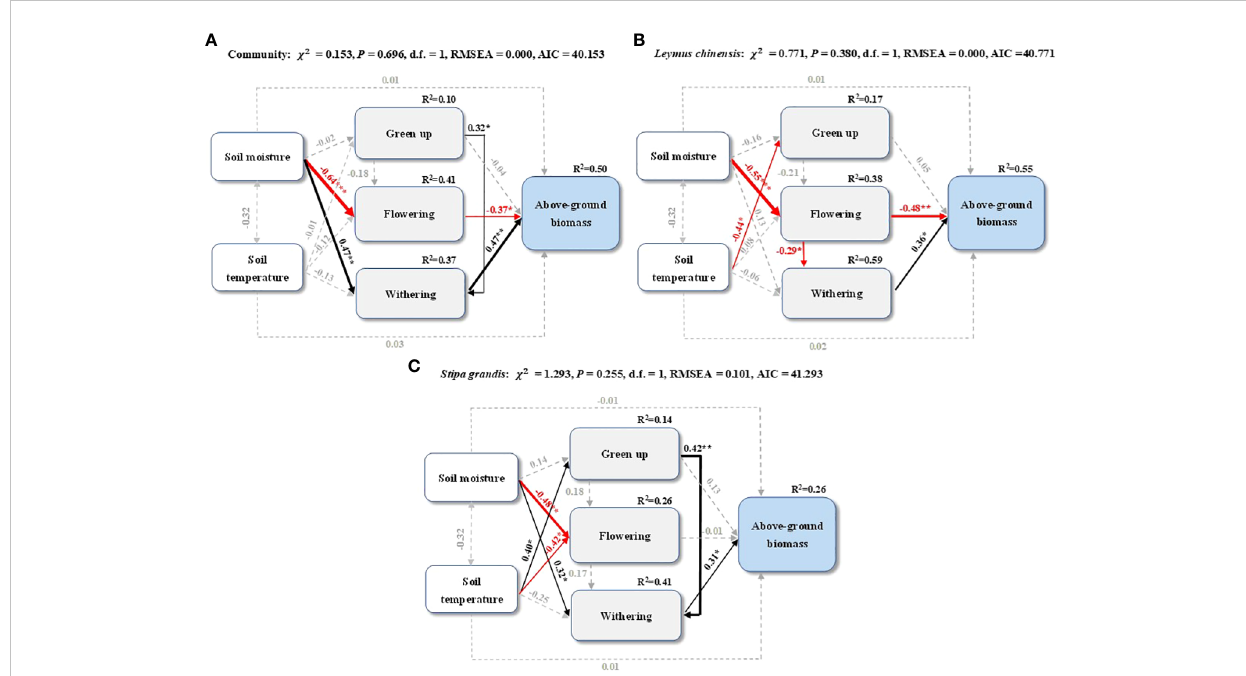
FIGURE 4 Structural equation models of soil moisture, soil temperature, green-up, fl owering, and senescence on the above-ground biomass of (A) community, (B) L. chinensis , and (C) S. grandis . Black and red arrows represent signi fi cant positive and negative pathways, respectively, and grey dashed arrows indicate non-signi fi cant pathways. The arrow width is proportional to the strength of the relationship. The numbers adjacent to the arrows are standardized path coef fi cients and indicate the effect size of the relationship. The proportion of variance explained (R 2 ) appears alongside the response variables in the model, and the asterisks indicate statistical signi fi cance (*P < 0.05, **P < 0.01, ***P <